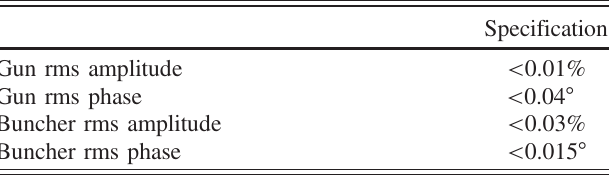
TABLE II. Gun and buncher field regulation